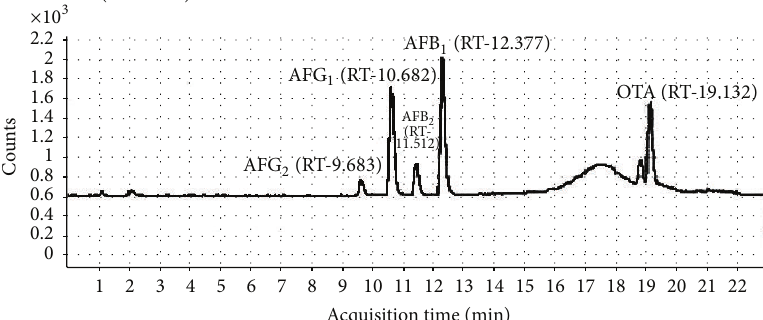
Figure 3: LC-MS/MS chromatogram of AFs (AFB 1 , AFB 2 , AFG 1 , and AFG 2 ) and OTA for red chilli sample having maximum